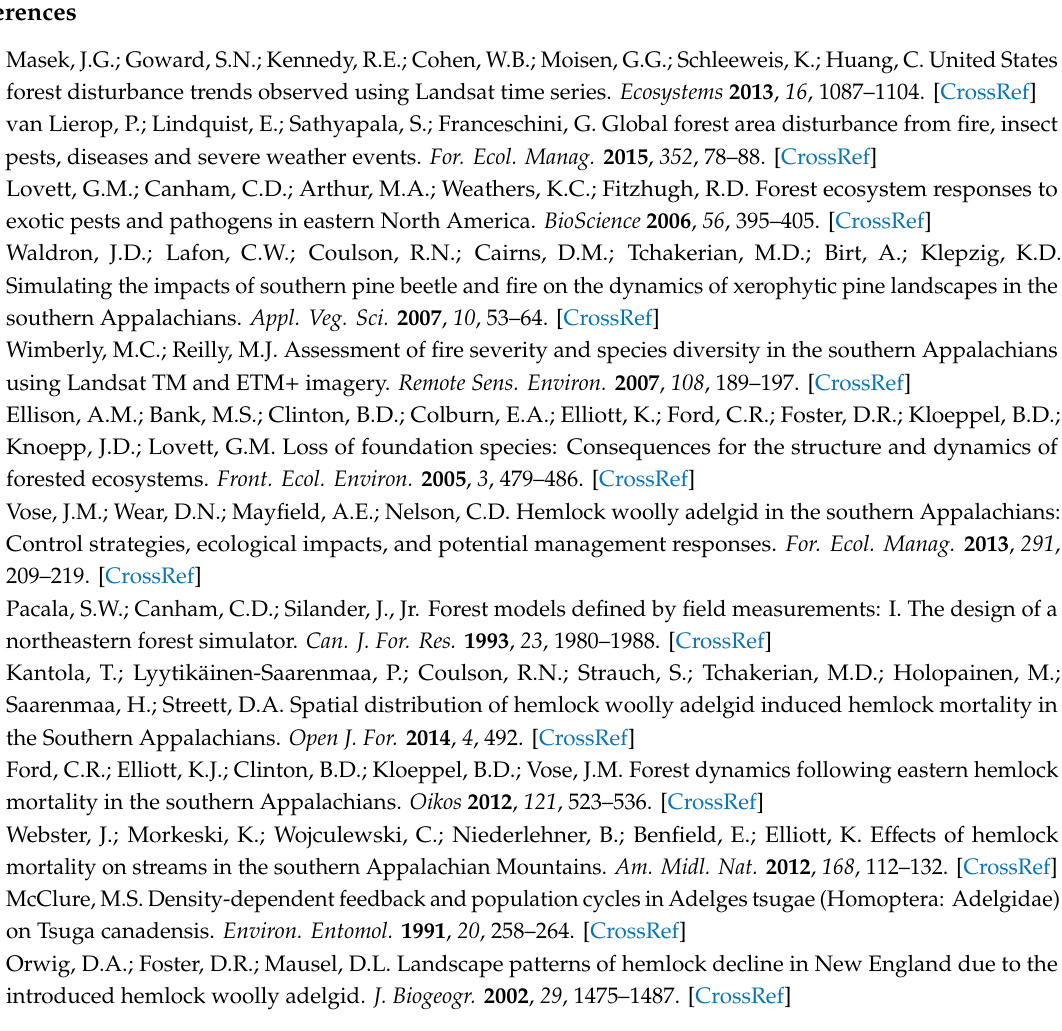
Figure S1: The spectral trajectory of TCB, TCG, EVI, B / G, B / W, and DI; their residuals; and the mean values within 1-year moving windows with 3-month steps at a Landsat pixel with a fire in 2007. Figure S2: The spectral trajectory of TCB, TCG, EVI, B / G, B / W, and DI; their residuals; and the mean values within 1-year moving windows with 3-month steps at a Landsat pixel with 12 dead hemlocks. Figure S3: Boxplots of indices’ maximum disturbance magnitude as a function of the number of dead hemlocks in a pixel. Figure S4: The spectral trajectories of NDVI for a Landsat pixel with both 2000 and 2007